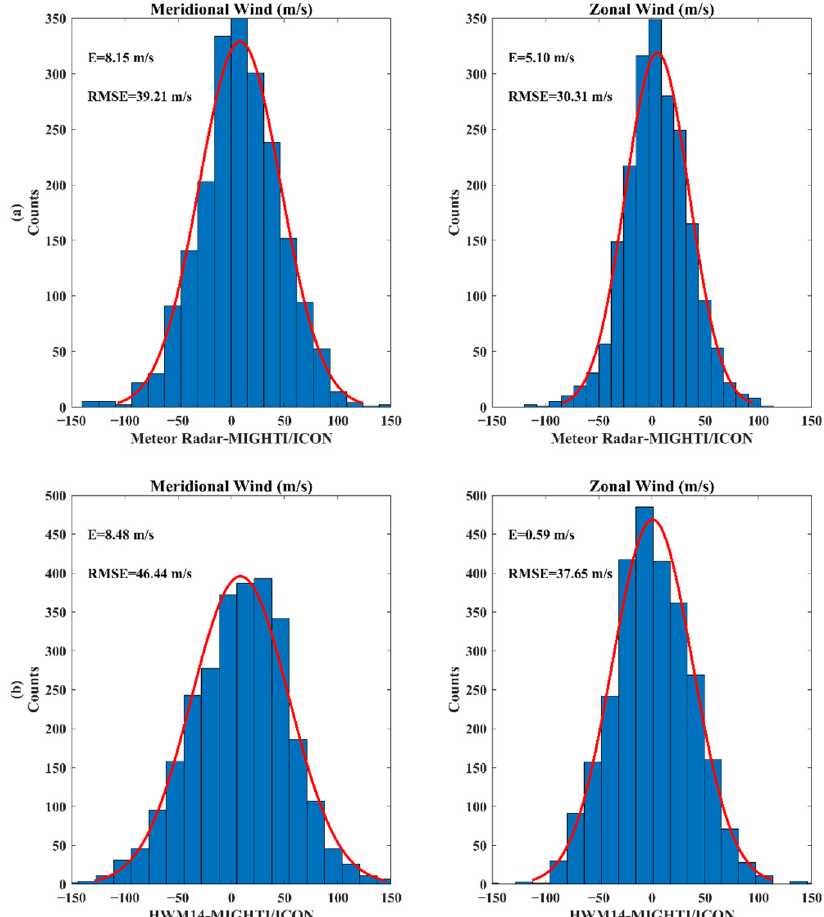
Figure 4. The distributions of the difference among the horizontal wind measurements from MIGHTI/ICON, meteor radar, and HWM14. The left side is for meridional winds, and the right side is for zonal winds. ( a ) Meteor Radar-MIGHTI/ICON; ( b ) HWM14-MIGHTI/ICON.